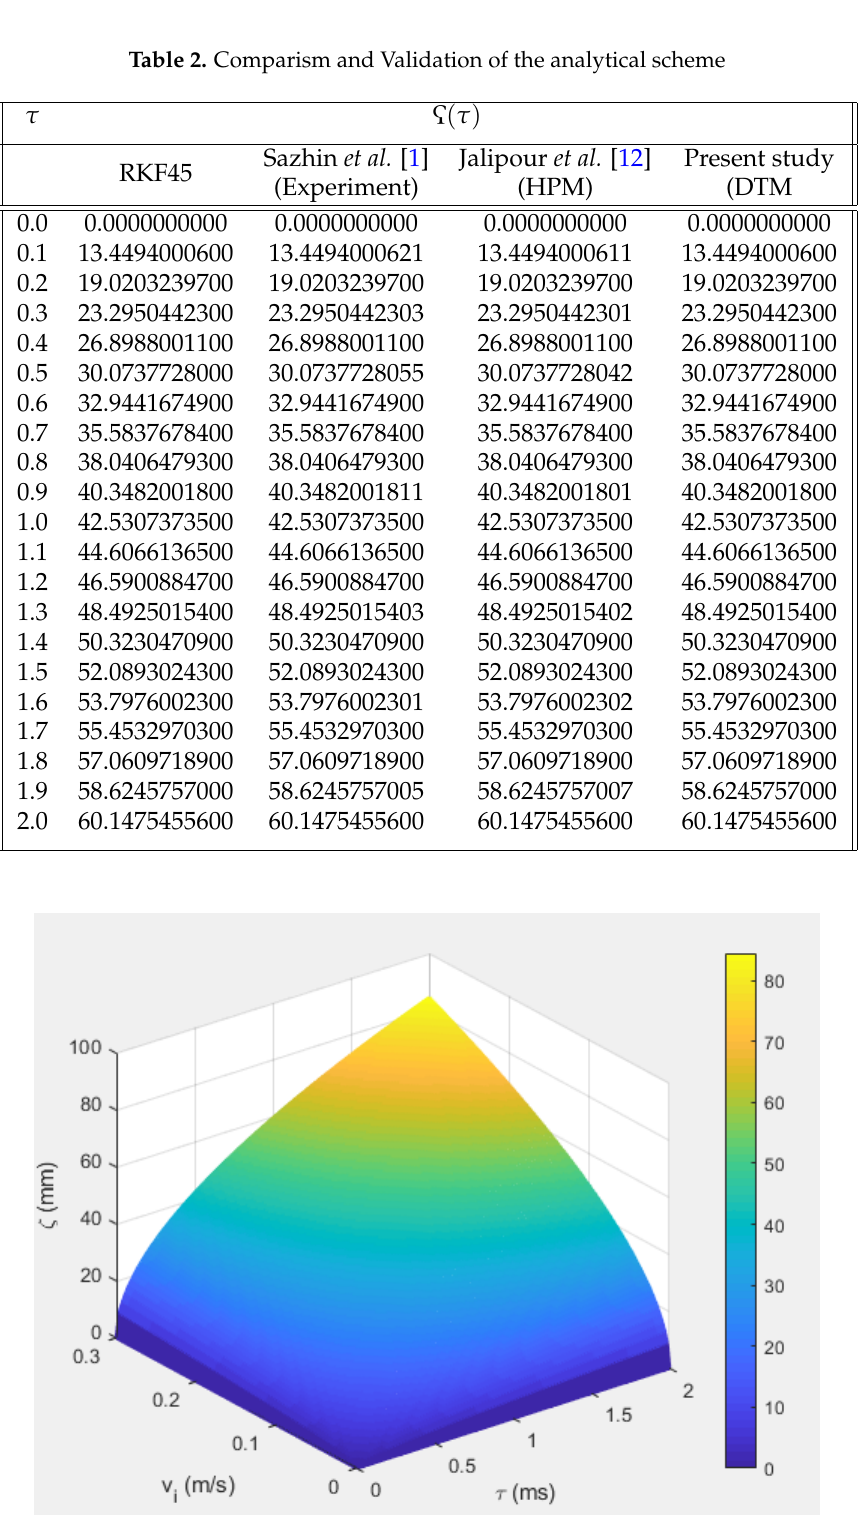
Figure 10. Dynamic impact of droplet initial